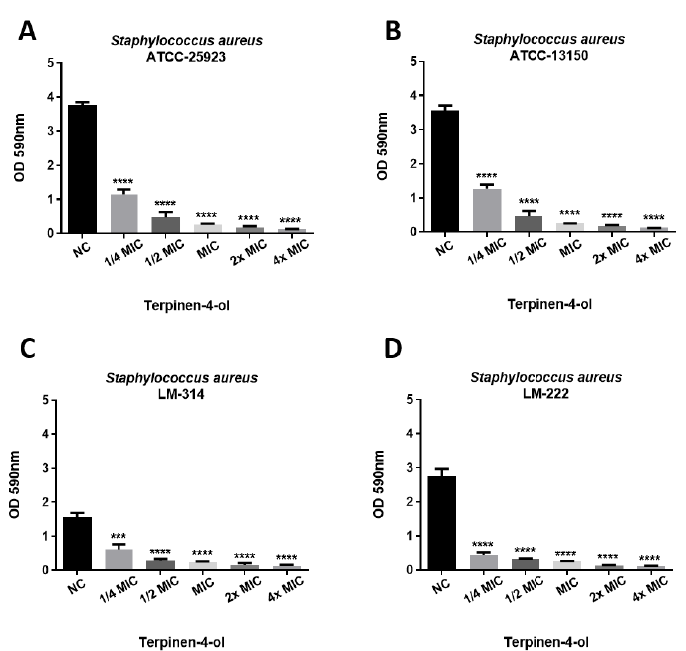
Figure 3. Effect of terpinen-4-ol on the inhibition of biofilm formation by different S. aureus strains: ( A ) ATCC-25923; ( B ) ATCC-13150; ( C ) LM-314; ( D ) LM-222. NC: negative control. Statistical analysis, compared to the negative control: **** p ≤ 0.0001; *** p ≤ 0.001. MIC: Minimum Inhibitory Concentration.